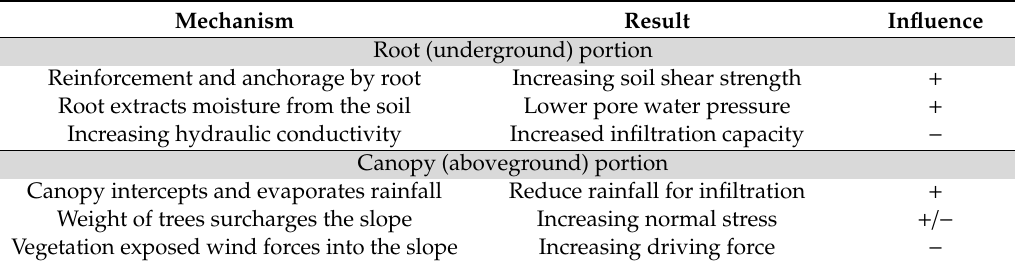
Table 1. Influences of vegetation on slope stability